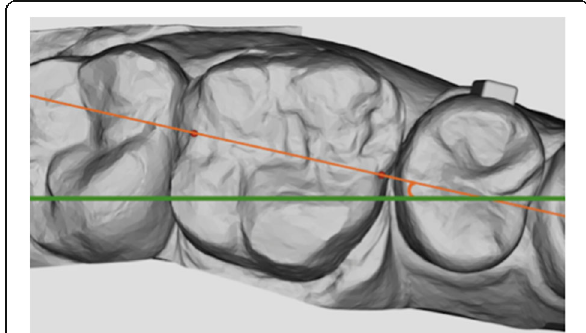
Fig. 4 Rotation: the angle between the mesiodistal axis of the tooth and plane y